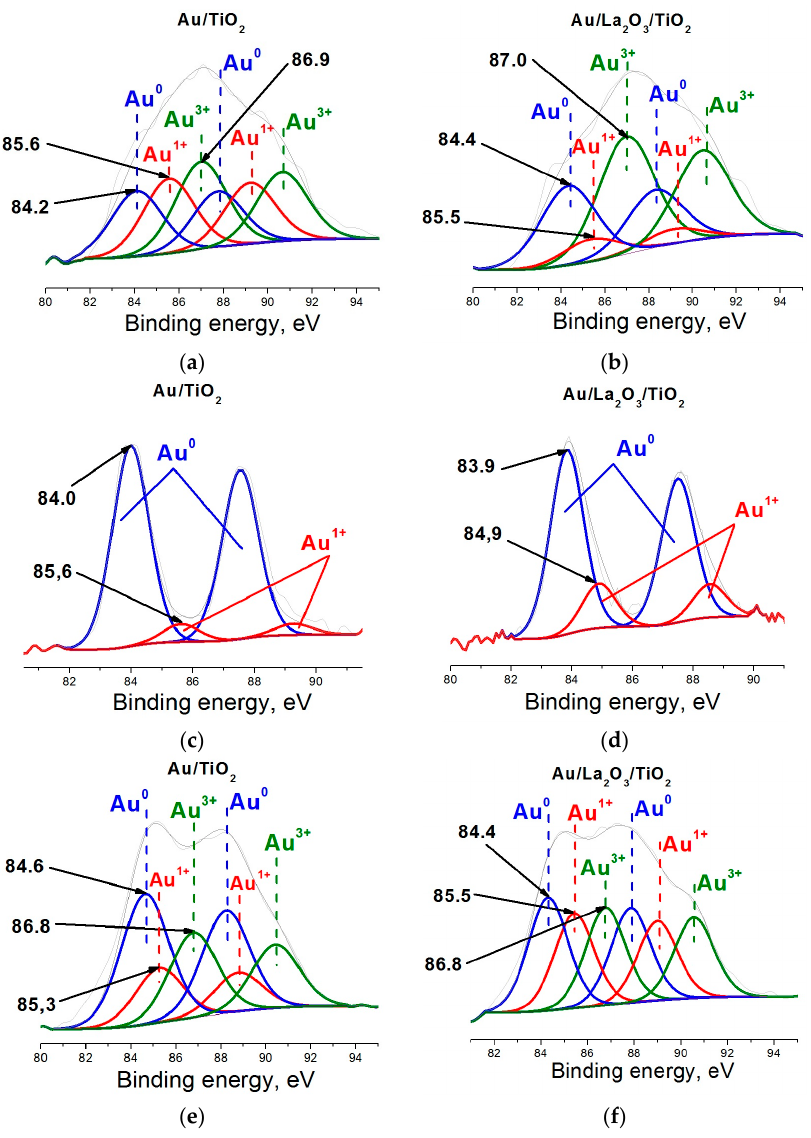
Figure 4. Au4f XPS spectra of Au/TiO 2 ( a , c , e) and Au/La 2 O 3 /TiO 2 ( b , d , f ). Catalyts: as-prepared ( a , b ); after use in reaction ( c , d ); and after long term storage ( e , f ).